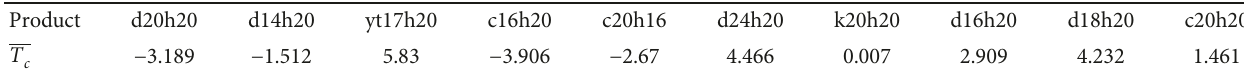
Table 3: T of the 10 products at the end of the normal printing stage. c